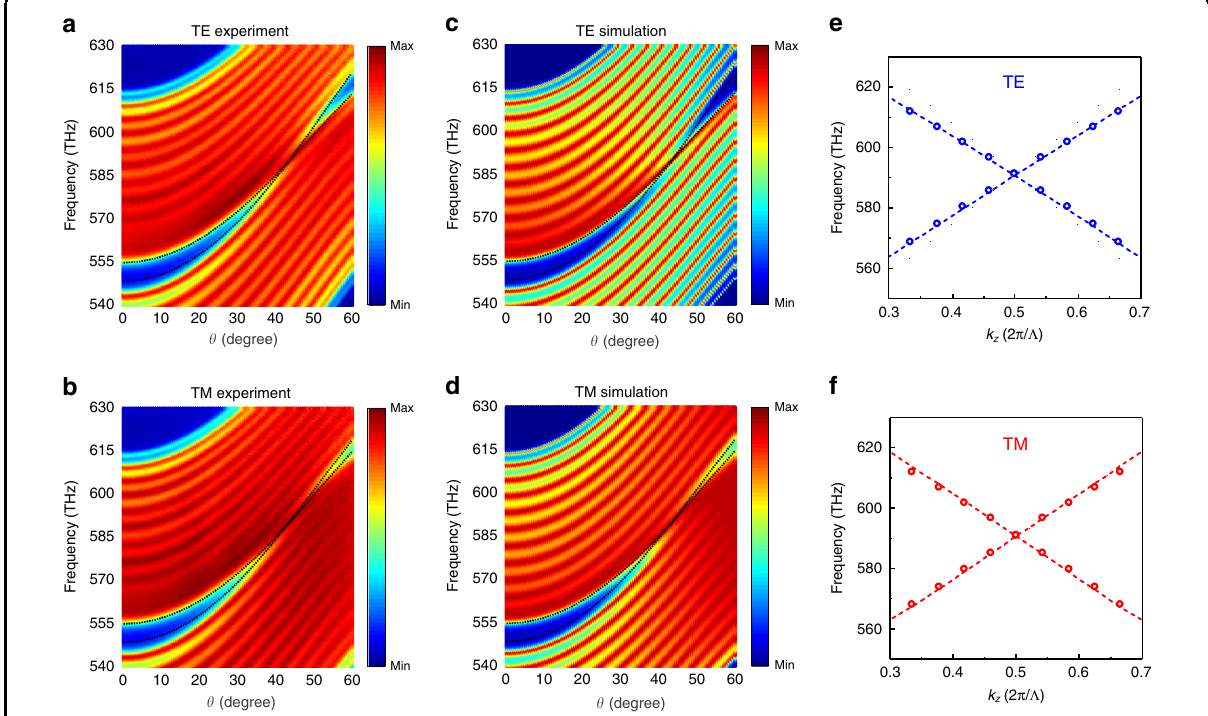
Fig. 2 Experimental observation of photonic DNR. a , b Measured and c , d simulated transmission spectra for the PC sample as the incident angle varied from 0 o to 60 o for the TE and TM plane-wave excitations. The transmission spectra fi ll the region bounded by the bulk bands (black dashed lines) along the k x direction at k z ¼ π = Λ . e , f Extracted dispersions along k z from the Fabry-Perot interference pattern for e TE and f TM polarizations, in which the open circles are acquired from the transmission peaks. The dashed lines are theoretical results for reference. The dielectric and geometric parameters of the PC are the same as those shown in Fig.